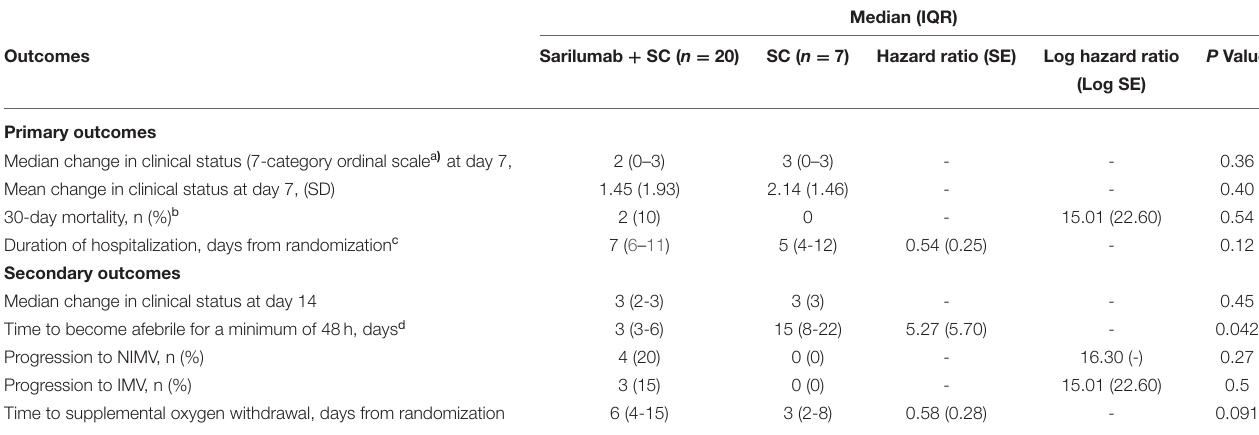
TABLE 5 | Clinical outcomes in the sensitivity analysis population.